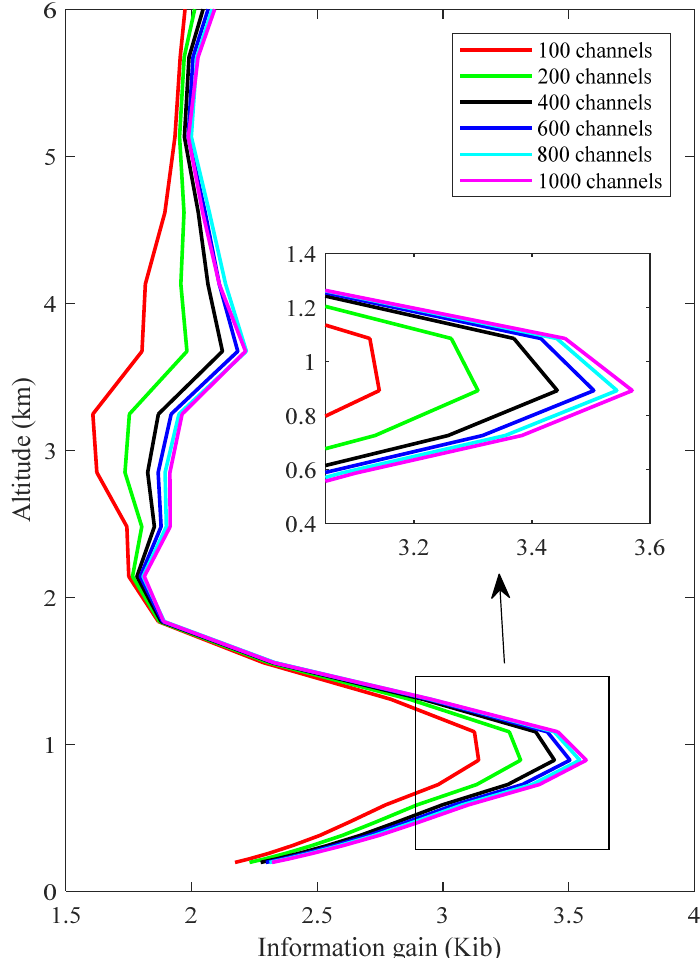
Figure 3. The simulation results of the number of channels and the information gain. The unit of information gain is expressed as “Kibibit,” abbreviated as “Kib,” and 1 Kib = 1024 bit. The larger the value of information gain, the larger the amount of information contained in the atmospheric spec- trum.